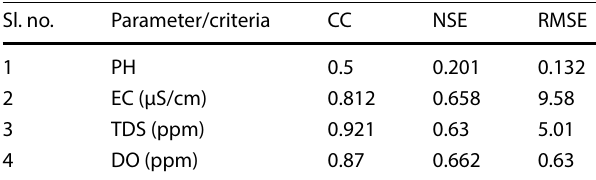
Table 3 ANN model performance for the next year data prediction Sl. no.